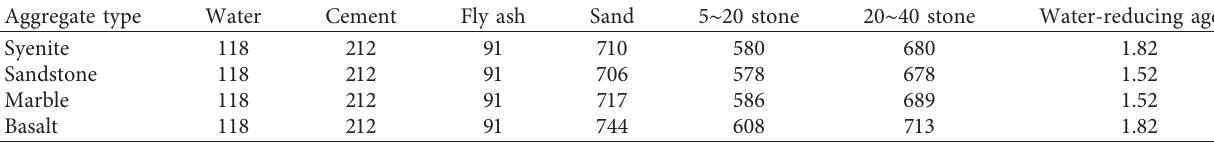
Table 9: Mix proportion of concrete (kg/m 3 ).